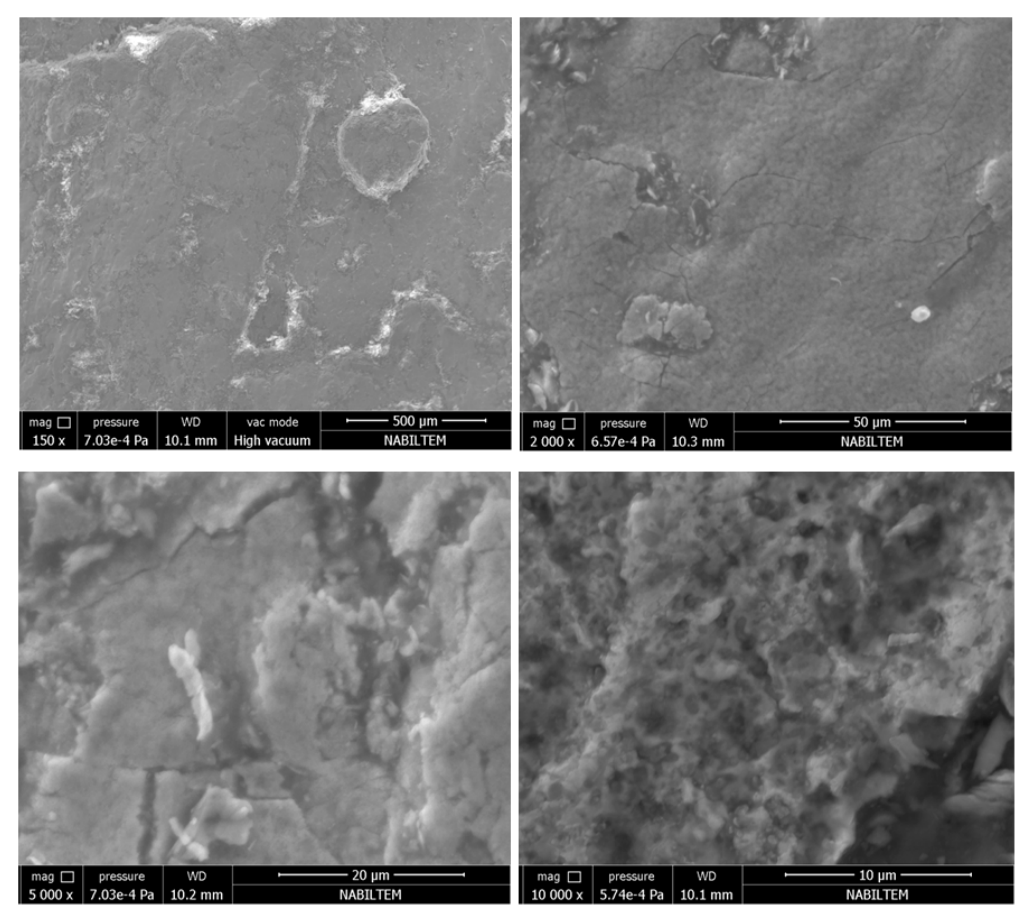
Figure 9. Scanning electron microscope test of the friction welded rod.